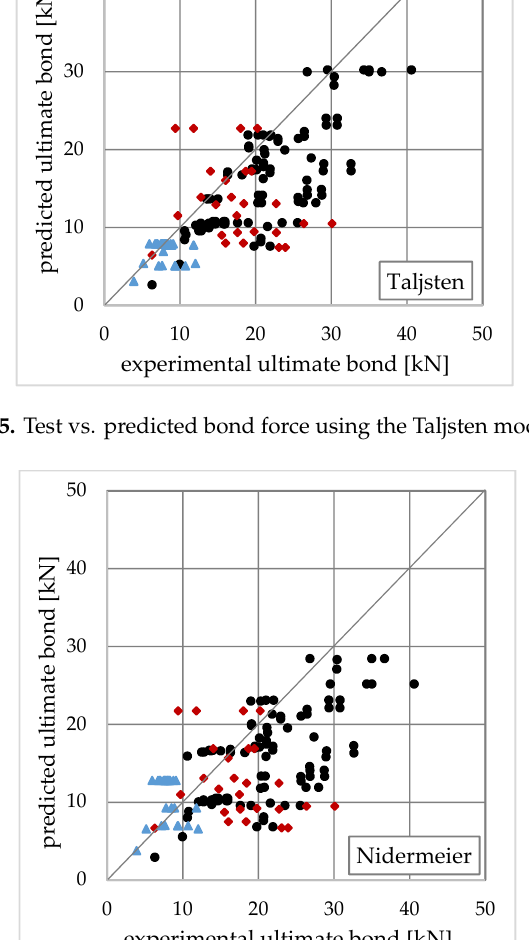
Figure 6. Test vs. predicted bond force using the Nidermeier model [18].